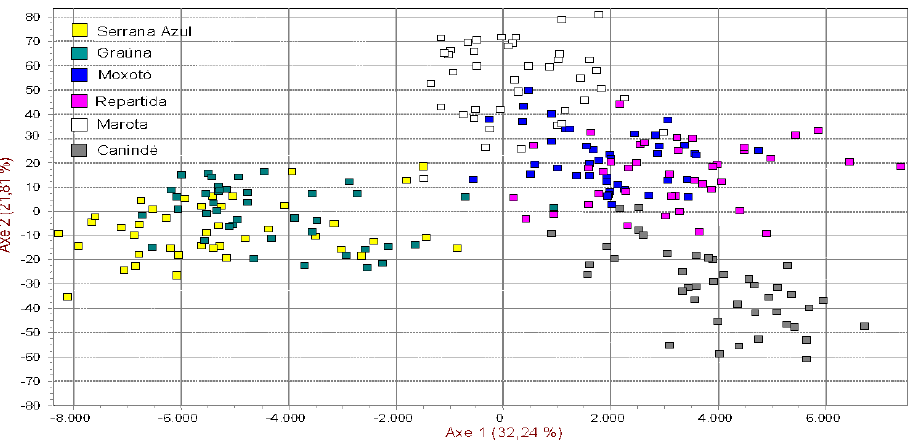
Figure 2. Spatial representation of Brazilian breeds using factorial correspondence analysis.